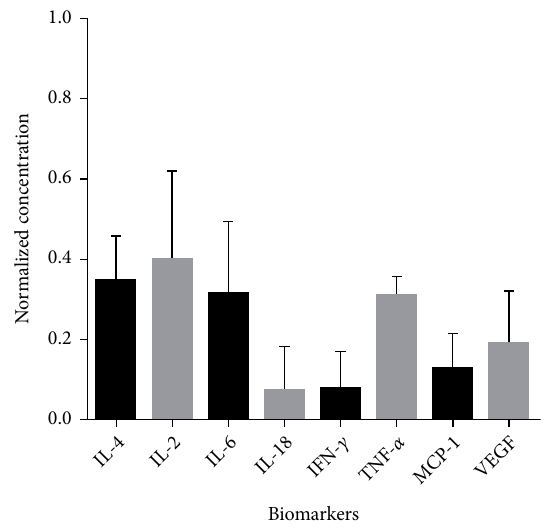
Figure 10: Normalized concentration of each biomarker in the conditioned medium of OM-MSCs (mean ±